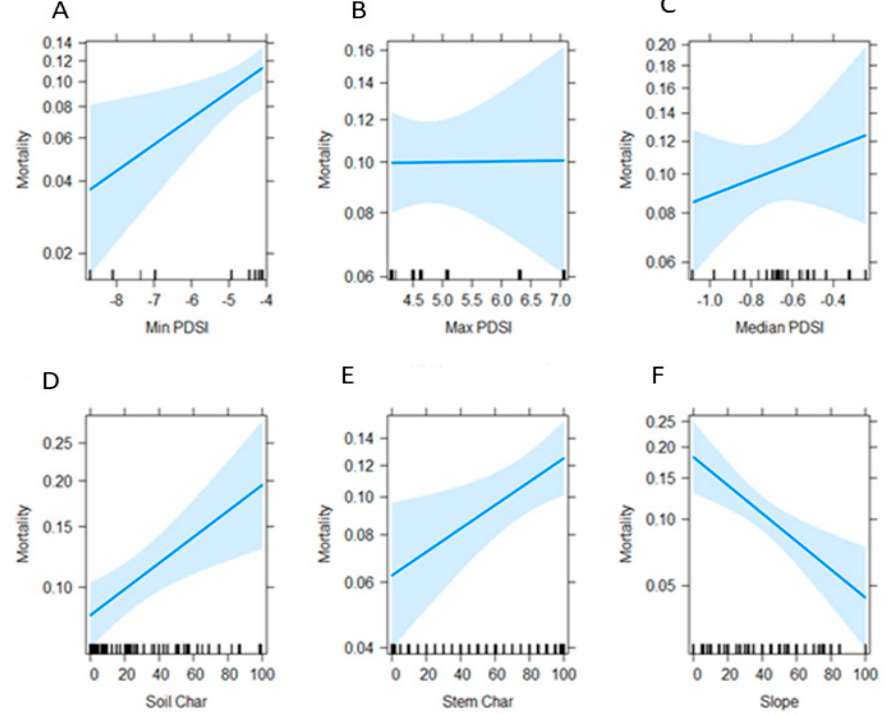
Figure 3. Effects plots showing probability of delayed mortality from logistic model for minimum PDSI ( A ), maximum PDSI ( B ), median PDSI ( C ), soil char ( D ), stem char ( E ), and slope ( F ). These plots hold other model terms constant at zero using R Effects package [31].